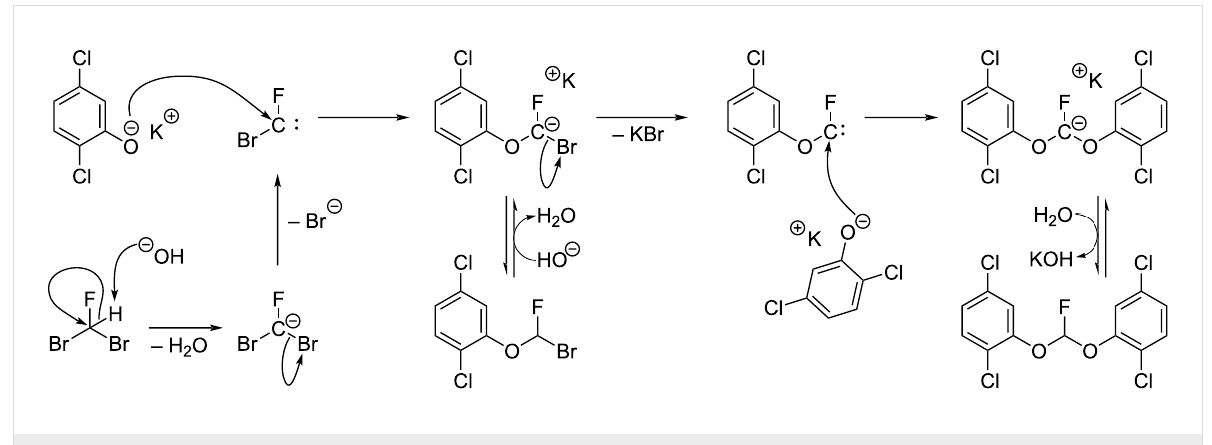
Scheme 7: Proposed mechanism for the formation of compound 11